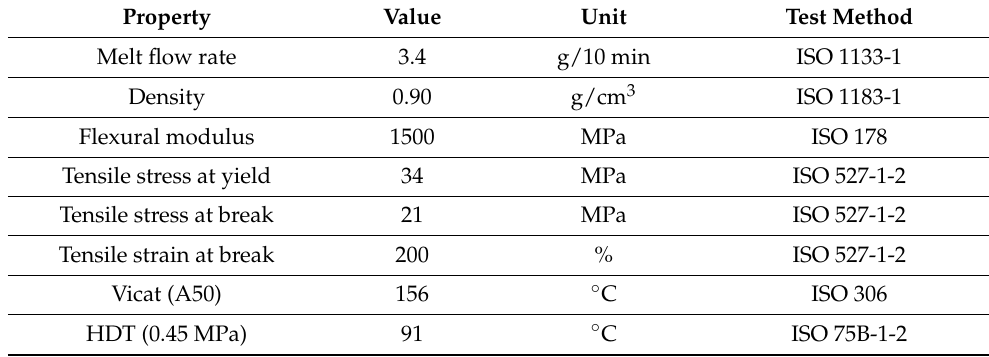
Table 8. Main thermo-mechanical properties of Moplen HP456J from the technical datasheet. Property Value Unit Test Method Melt flow rate 3.4 g/10 min ISO 1133-1 Density 0.90 g/cm 3 ISO 1183-1 Flexural modulus 1500 MPa ISO 178 Tensile stress at yield 34 MPa ISO 527-1-2 Tensile stress at